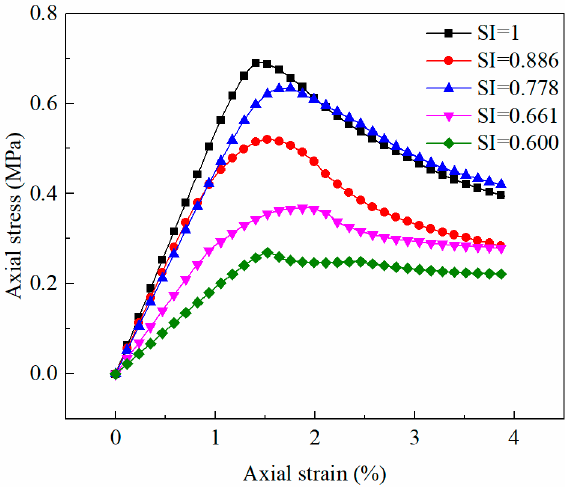
Figure 11. Macroscopic static response of soils as a function of pore sphericity.